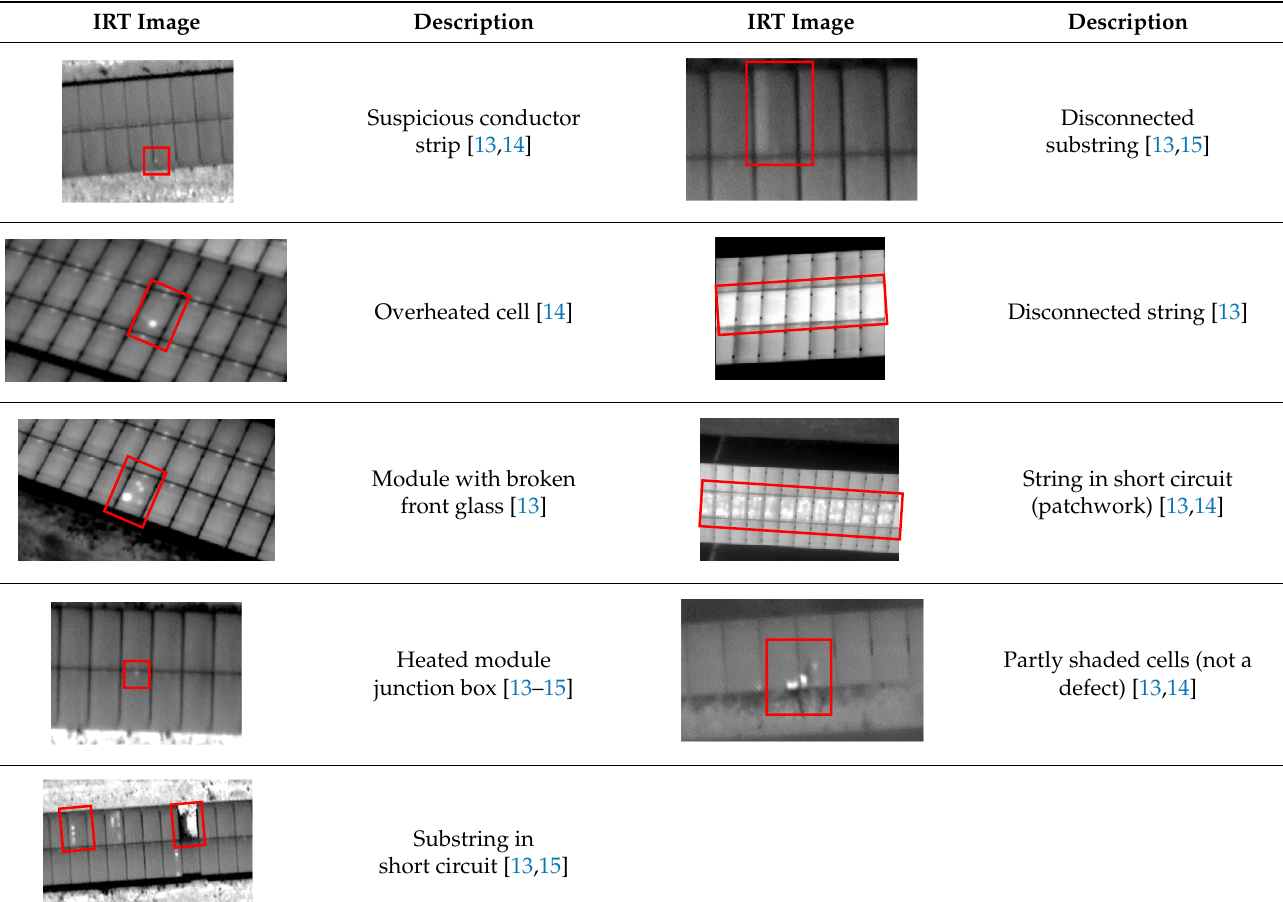
Table 1. Examples of IRT images of typical faults in PV systems.